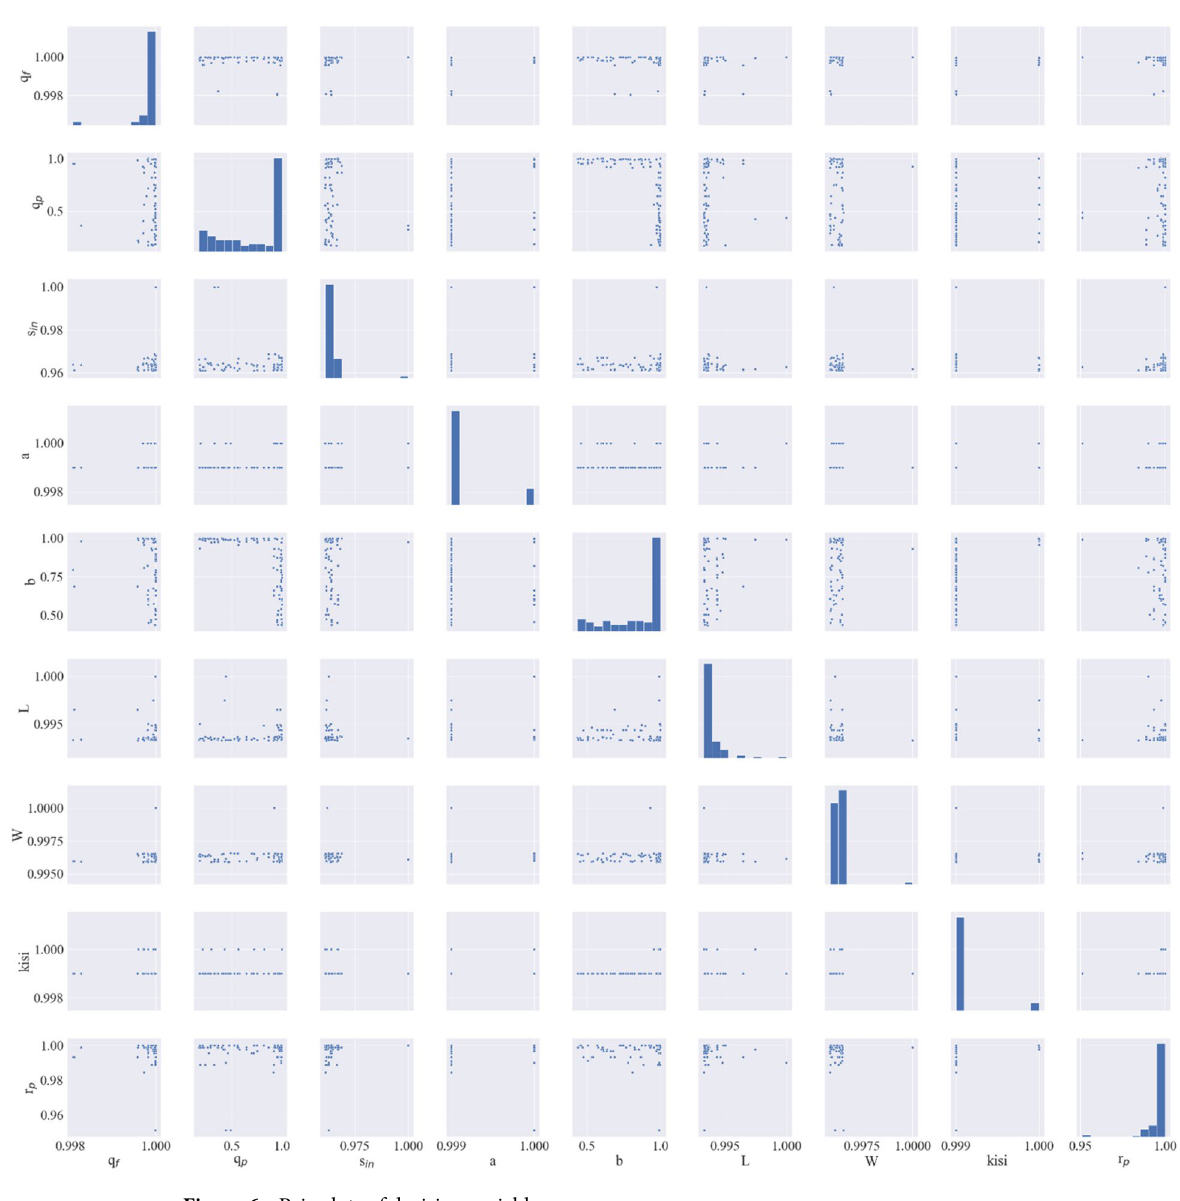
Figure 6. Pair plots of decision